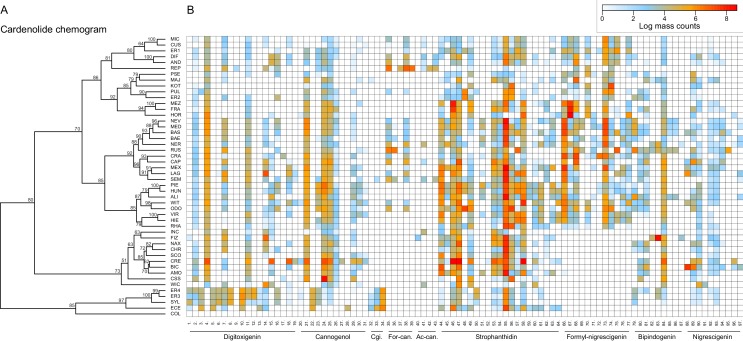
Cardenolide compound diversity and abundance accross 48 Erysimum species.(A) Chemogram clustering species by dissimilarities in cardenolide profiles. Values at nodes are confidence estimates (approximately unbiased probability value, function pvclust in R) based on 10,000 iterations of multiscale bootstrap resampling. (B) Heatmap of cardenolide profiles expressed by the 48 Erysimum species. Color intensity corresponds to log-transformed integrated ion counts recorded at the exact parental mass ([M+H]+ or [M+Na]+, whichever was more abundant) for each compound, averaged across samples from multiple independent experiments. The species E. collinum (COL) only expressed trace amounts of cardenolides, which are not visible on the color scale. Compounds are grouped by shared genin structures. Cgi. = Cannogenin, For-can.=Formyl cannogenol, Ac-can.=Acetyl cannogenol. See Supplementary file 7 for additional compound information.